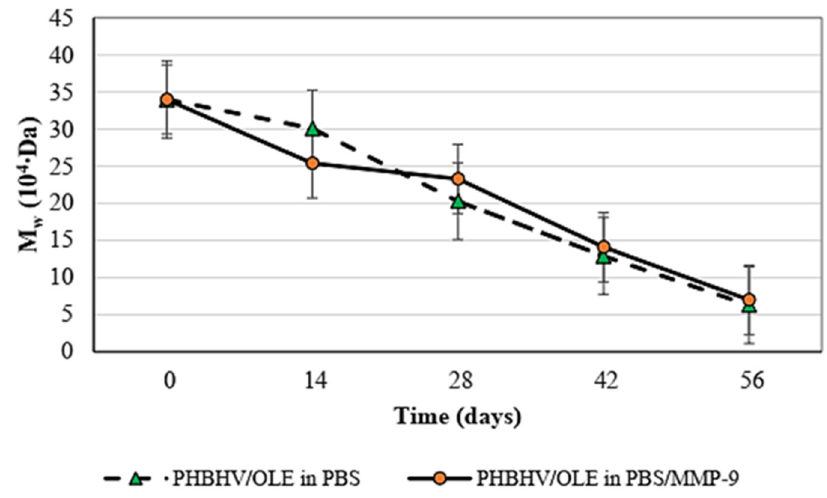
Figure 4. Graph showing molecular weight (M w ) loss obtained from GPC of PHBHV/OLE fiber meshes for 8 weeks in different media: plain PBS and PBS added with MMP-9 at 50 ng/mL ( n = 4).